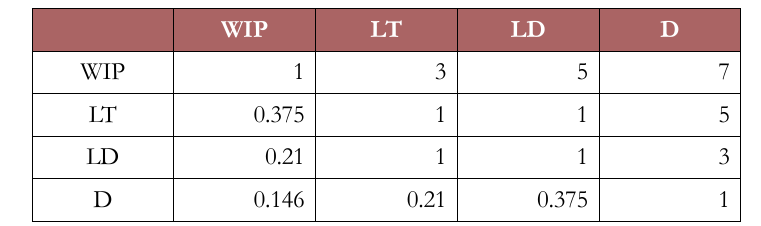
Table 6. Eigenvector for comparison matrix of the criteria